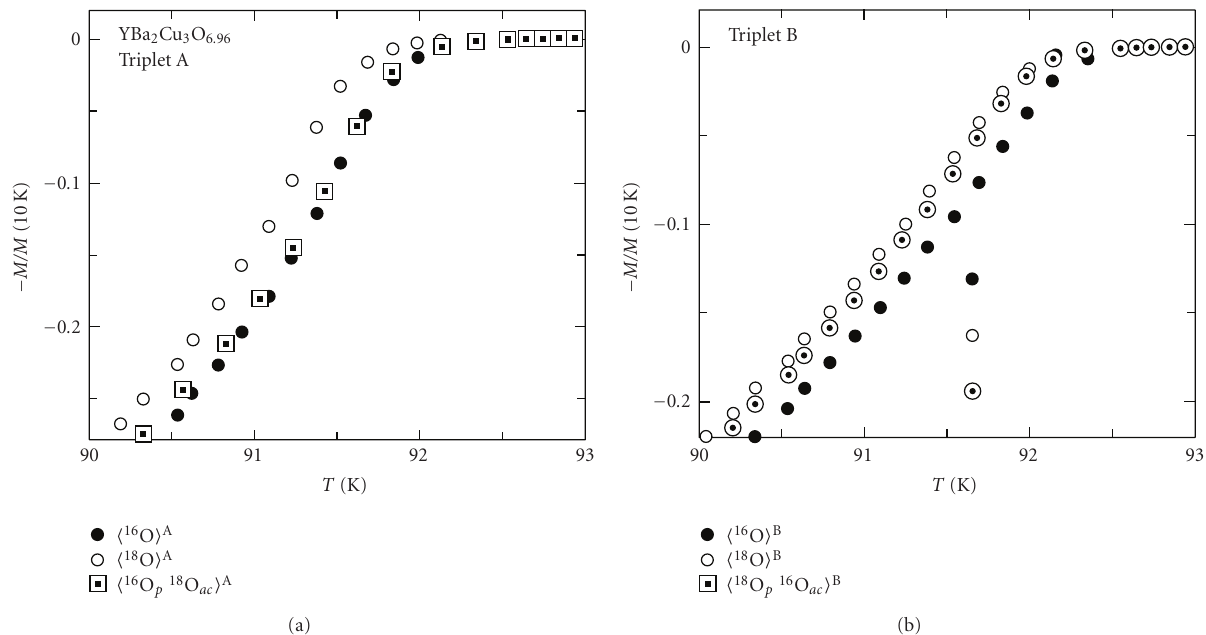
Figure 2: Magnetization curves near T c , showing the SOIE in optimally doped YBa 2 Cu 3 O 7 − δ for x = 6.957(2) (triplet A) and x = 6.963(3) (triplet B). Here p , a , and c denote the di ff erent oxygen ion sites in YBa 2 Cu 3 O 7 − δ ( p : planar oxygen ion sites; a : apical oxygen ion sites; c : chain oxygen ion sites). For example, (cid:3) 18 O p 16 O ac (cid:4) B denotes a sample from batch B with 18 O in CuO 2 planes and 16 O in the apical and chain sites. It is evident that the planar oxygen atoms mainly contribute to the total OIE on T c , after [55].